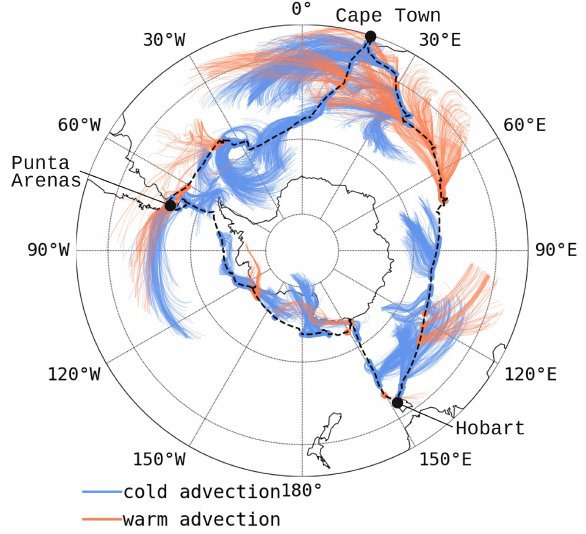
Figure 4. The 2d backward trajectories calculated with COSMO iso wind fields for warm (orange) and cold (blue) tempera- ture advection events as identified using (cid:49)T ao in COSMO iso along the ACE ship track (black, dashed line). The black dots denote the harbour stays at Cape Town (ZA) on 21 December 2016, Hobart (AUS) from 19 to 22 January 2017, Punta Arenas (CL) from 22 to 26 February 2017 and again in Cape Town on 19 March